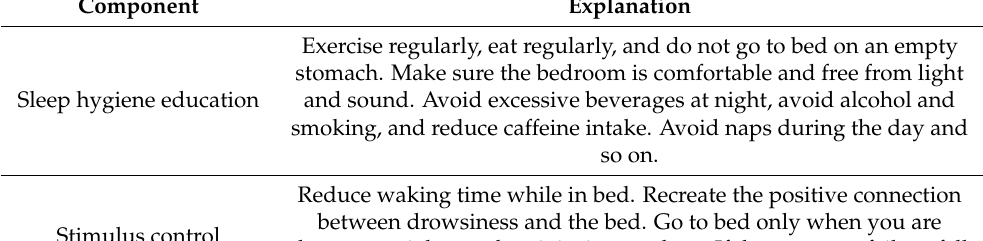
Table 1. The components of dCBT-i